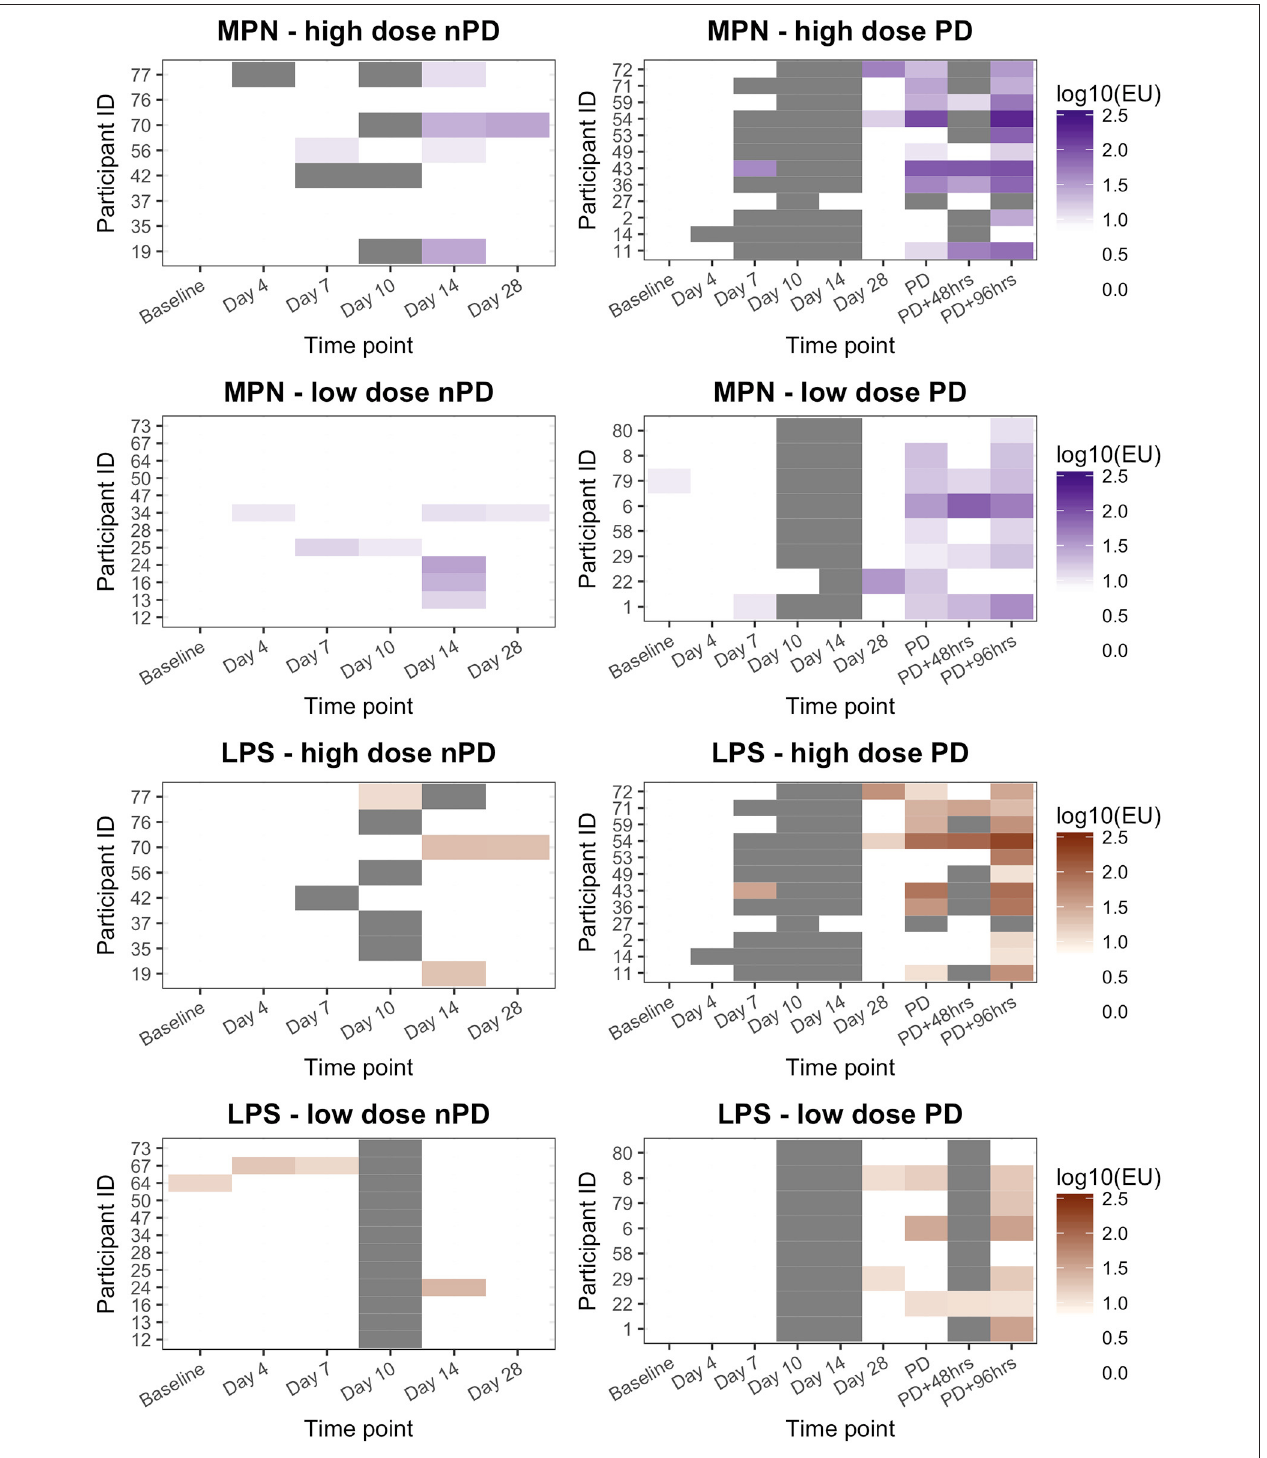
FIGURE 3 | ALS IgA responses to MPN or LPS in participants challenged with Salmonella Paratyphi A according to challenge dose level and challenge outcome. High dose, 1–5 × 10 3 CFU; Low dose, 0.5–1 × 10 3 CFU. nPD, paratyphoid not diagnosed; PD, paratyphoid diagnosed. “ White” indicates the titer was below the diagnostic cut-off (10EU). “ Gray” indicates sample not